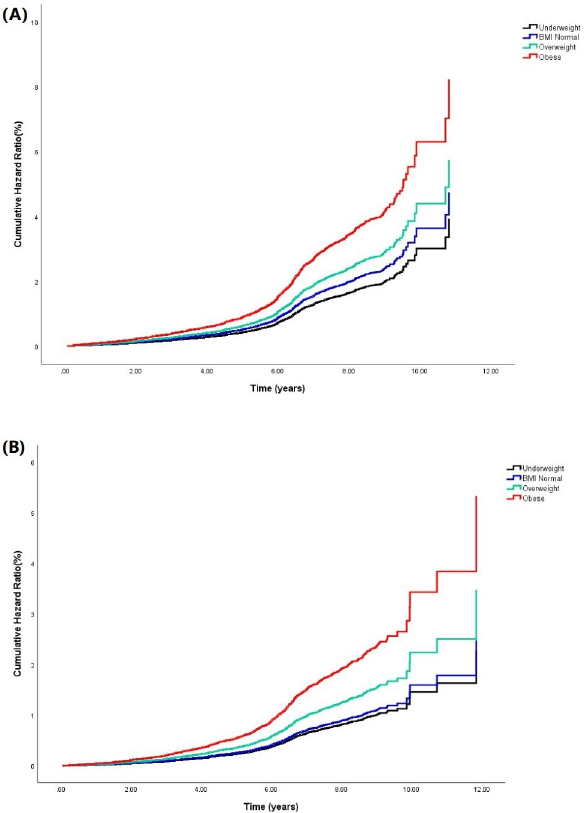
Fig 3. Kaplan-Meier survival curves of patients with different BMI categories (underweight, BMI normal, overweight, obese) with baseline CD4+ T cells < 200 cells/ μ L recovering to threshold. (A) Cumulative risk rate of recovery of CD4+ T cells to � 350 cells/ μ L in HIV-infected patients; (B) Cumulative risk rate of recovery of CD4+ T cells to � 500 cells/ μ L in HIV-infected patients.